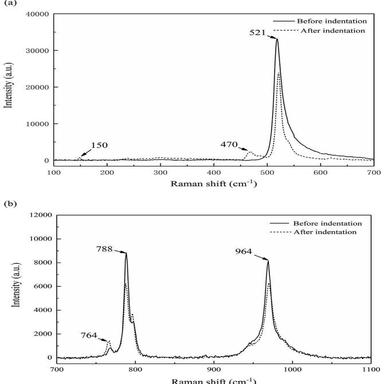
Raman spectrum of the Si and SiC phase before and after the indentation: (a) Si, (b) SiC.